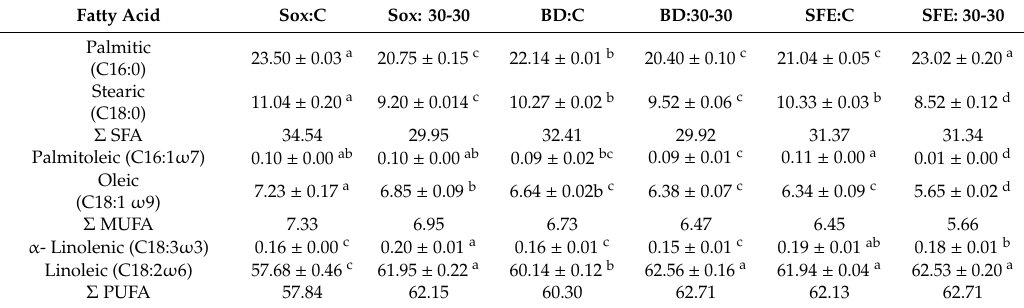
Table 3. Comparison of major fatty acid profile (% area) of grape seed oil samples obtained by three extraction methods (Sox, BD, and SFE) using ultrasound pretreatment (30:30) and their respective untreated controls